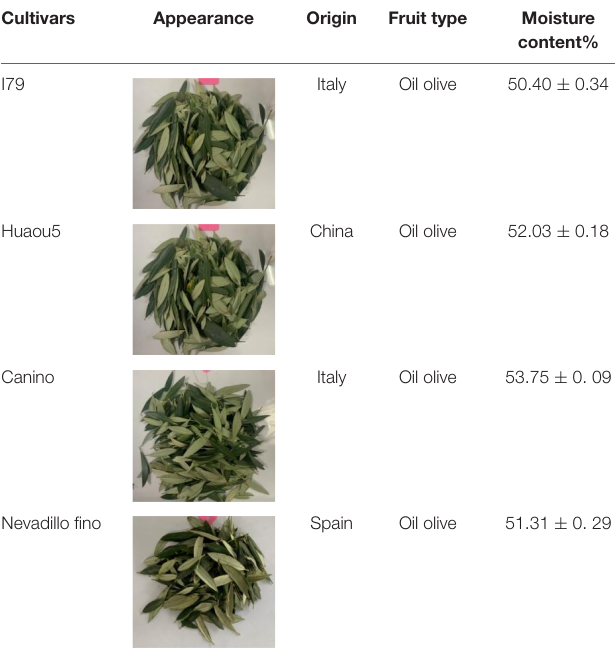
TABLE 1 | Four cultivars of olive leaves used in this